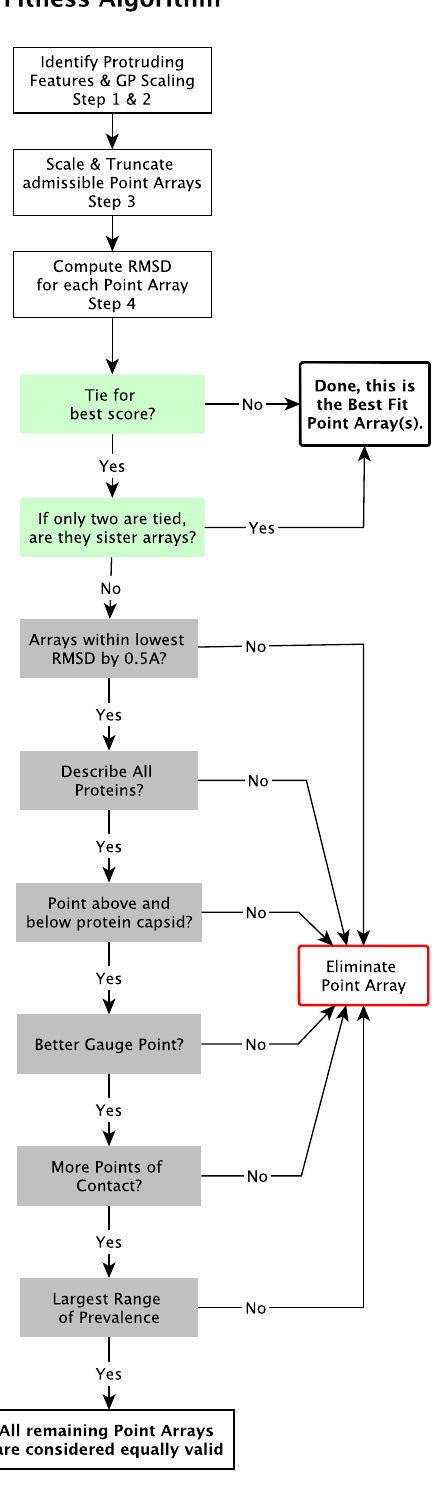
Figure 9. Schematic representation of the fitness algorithm for point array matching to viral capsids. Most viruses only have a few point arrays that have a low RMSD. Many ties are due to sister point